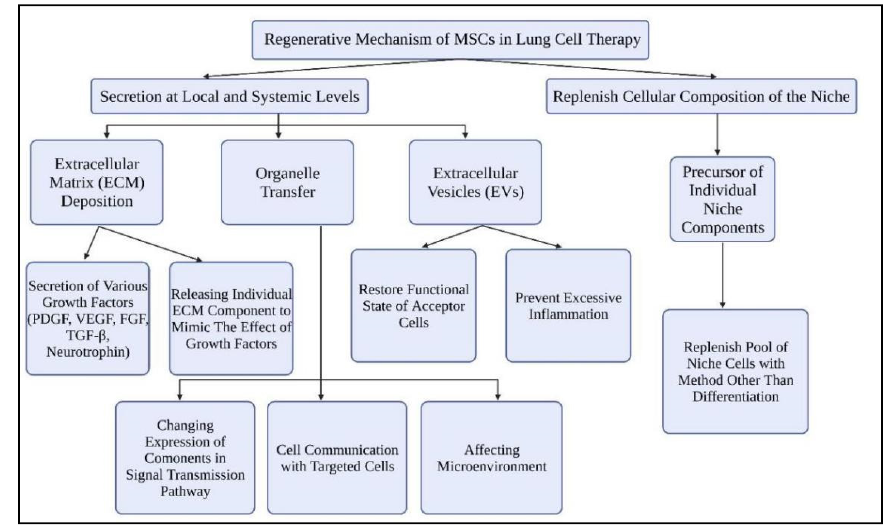
Figure 4. Summary of the regenerative mechanism of MSCs in lung cell therapy.